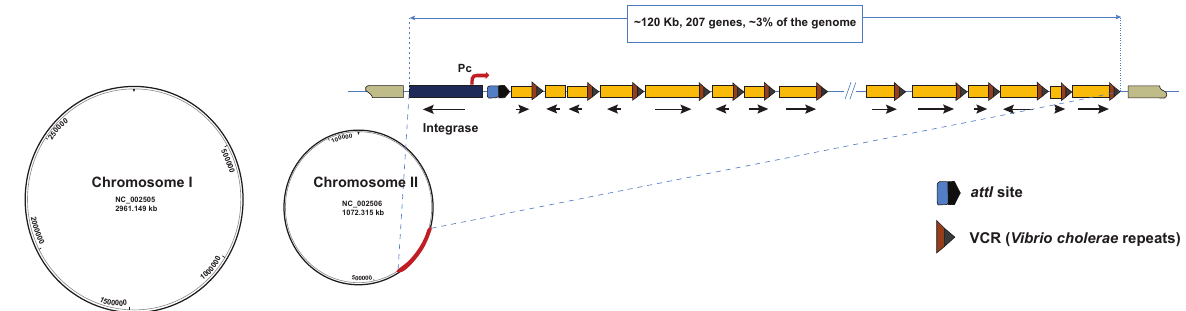
Figure 1. Schematic organization of the Vibrio cholerae genome and the superintegron (SI). The functional platform of the SI consists of an integrase gene, a cassette promoter (Pc), and a primary recombination site ( attI ). The system maintains an array of several cassettes, which generally consist of a promoterless ORF flanked by two recombination sites termed VCR ( V. cholerae